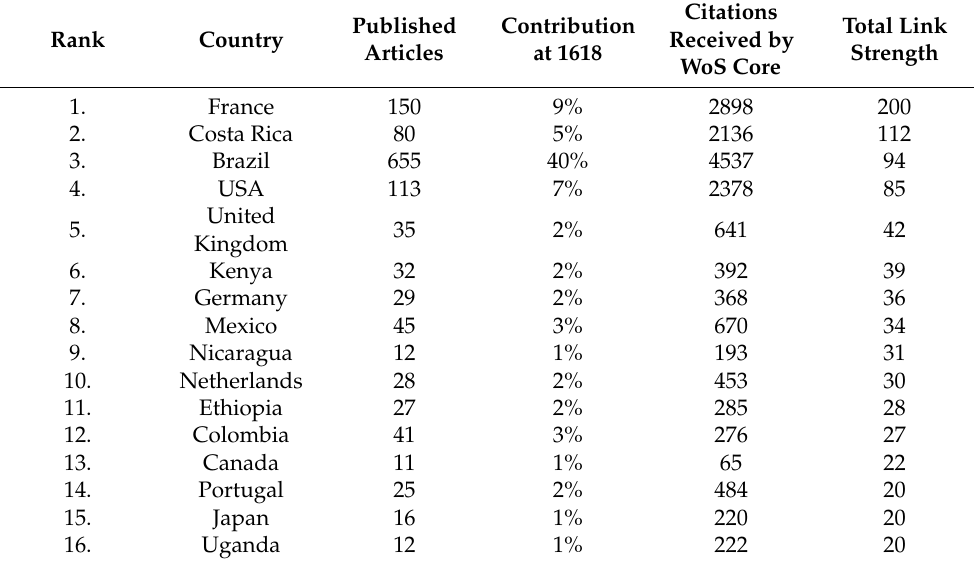
Table 3. Relevant countries in coffee agronomy research.